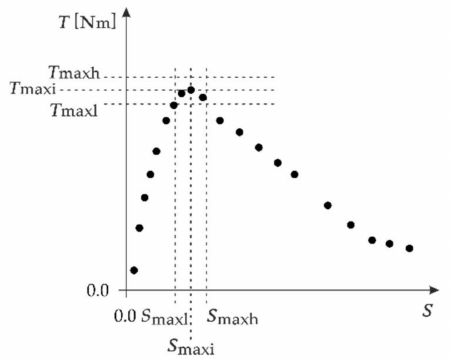
Figure 5. The typical TSC for the motor work of the